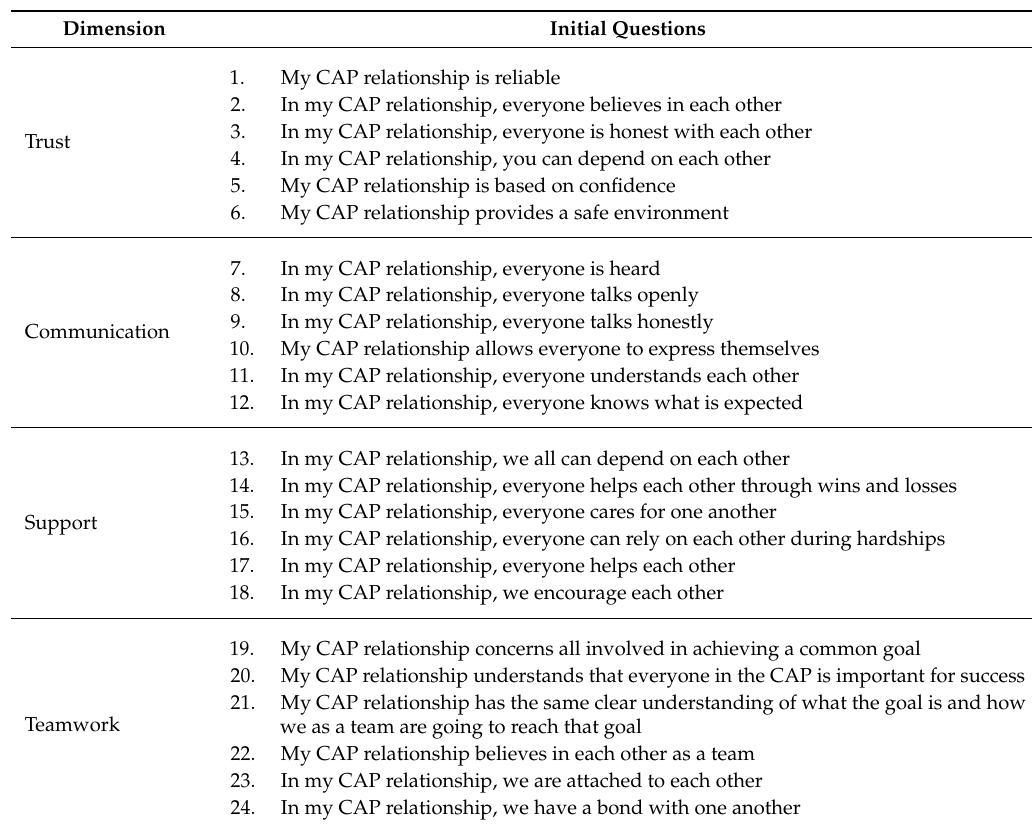
Table 1. Coach–athlete–parent (C-A-P) list of the original 48 items.